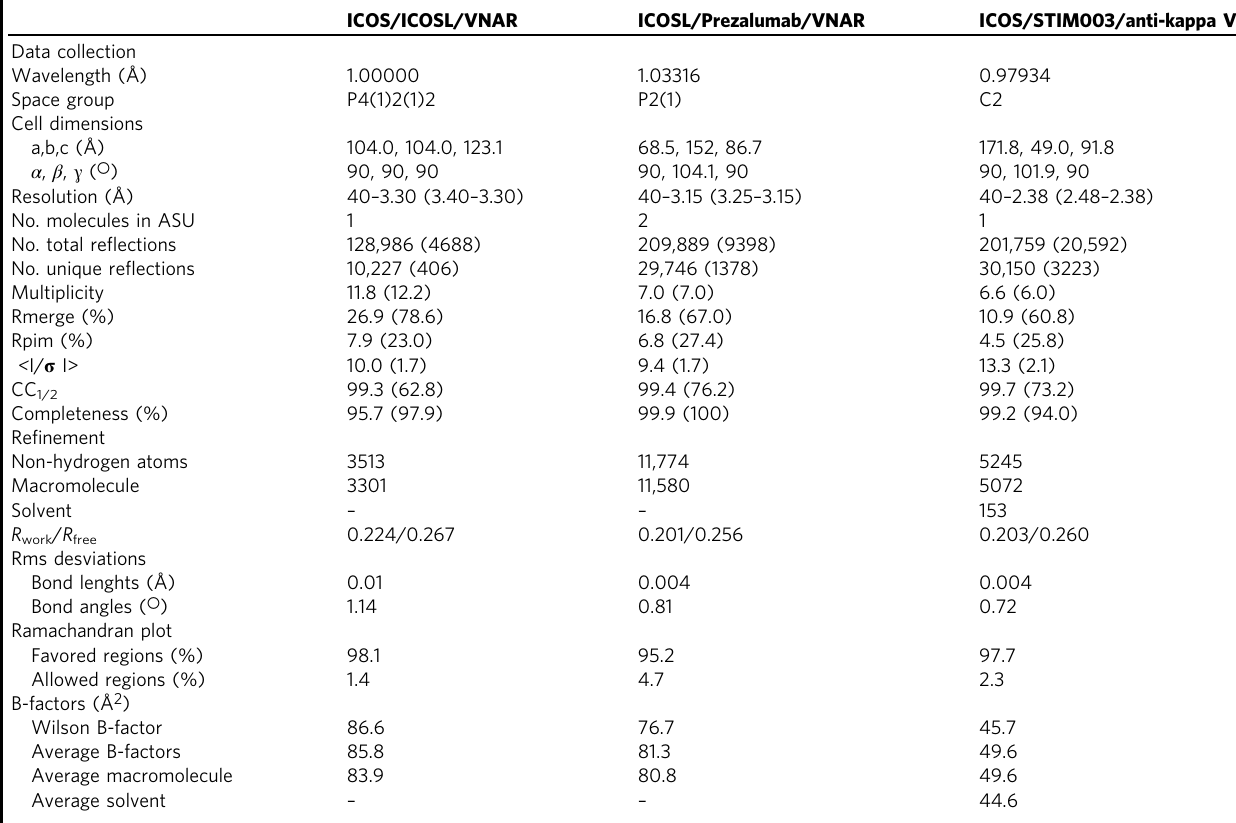
Table 1 Data collection and re fi nement